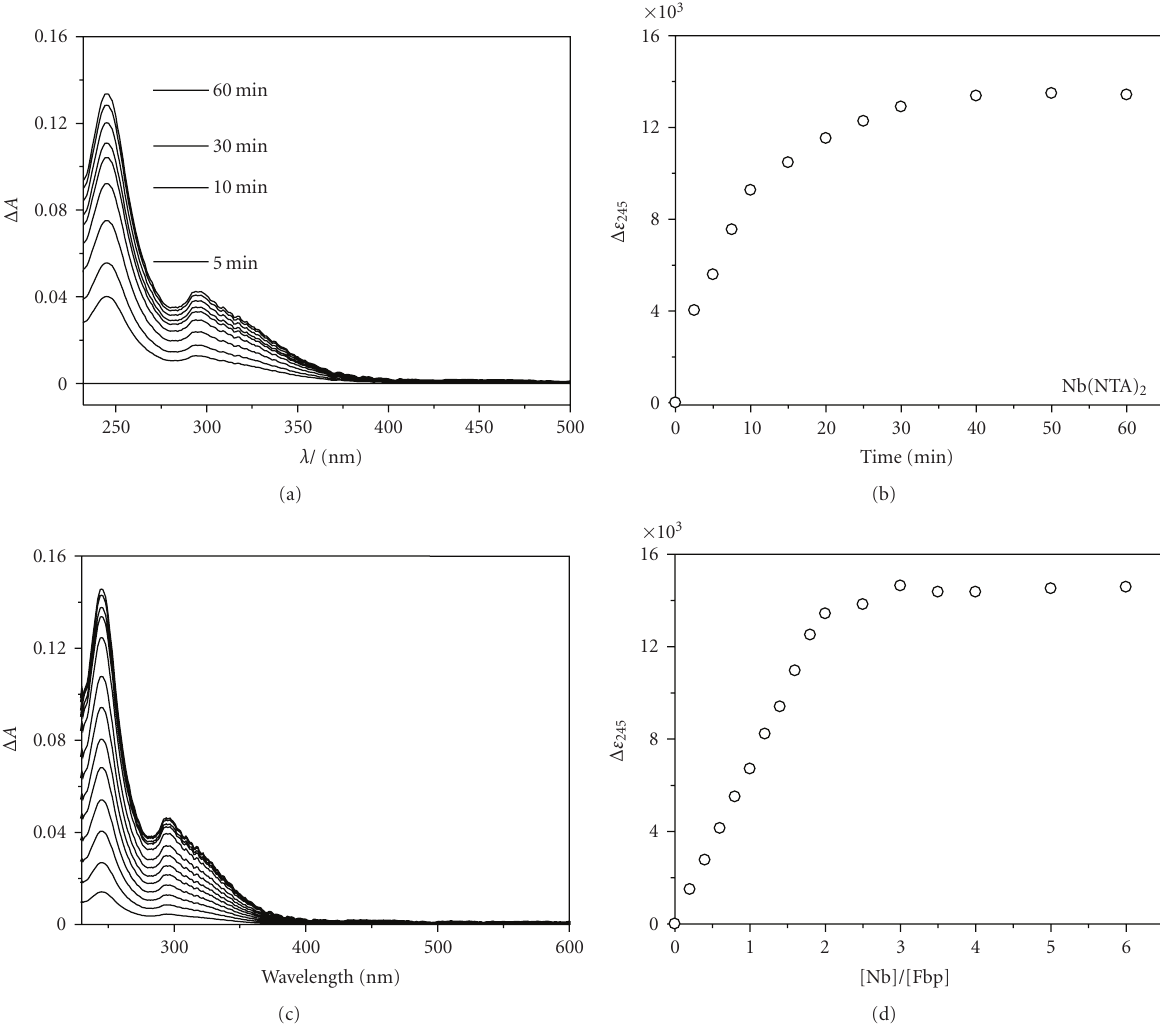
Figure 2: (a) UV di ff erence UV/Vis spectra recorded at various times during the reaction of apoFbp (10 μ M) with 2.0mol equivalents of [Nb(NTA) 2 ] − in 10 mM Hepes bu ff er, 5mM phosphate, pH 7.4, 310 K. (b) Time course for reactions of apo-Fbp (ca. 10 μ M) with 2